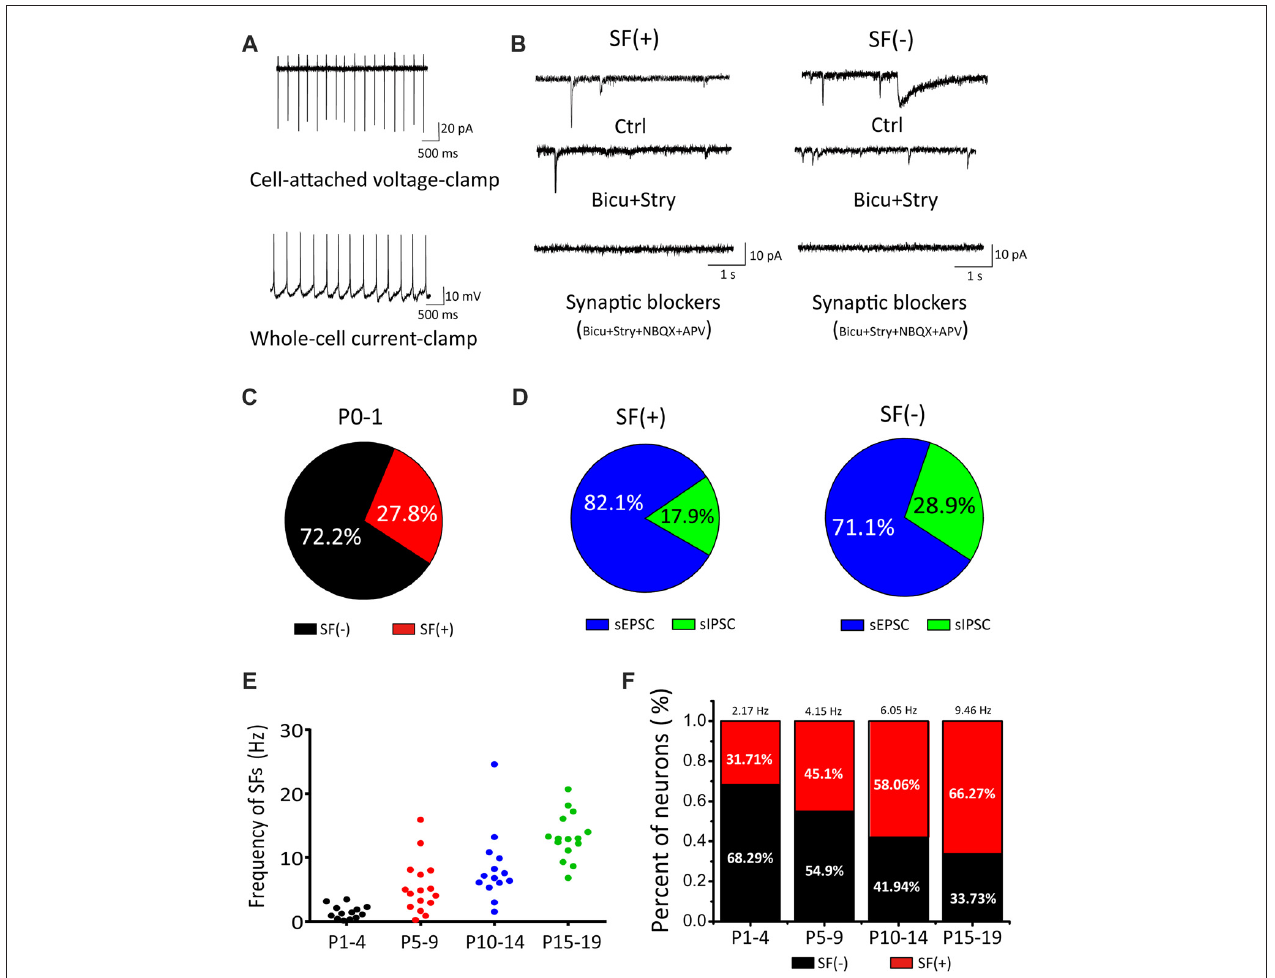
FIGURE 1 | Cochlear nucleus (CN) neurons exhibited spontaneous firings (SFs) in the early postnatal stage. (A) Examples showing cell-attached recordings of SFs in voltage-clamp or current-clamp mode. (B) Typical spontaneous synaptic currents recorded in three sequential conditions (control, bicu+stry, bicu+stry+NBQX+APV) in SF(+) and SF( − ) neurons. (C) Pie charts showing the percentage of SF(+) and SF( − ) neurons. (D) The proportion of spontaneous inhibitory postsynaptic currents (sIPSCs) and spontaneous excitatory postsynaptic currents (sEPSCs) detected in SF(+) and SF( − ) neurons, respectively. (E) A scattered dot plot showing developmental-dependent changes in the firing rate of 58 SF(+) CN neurons from P1–4, P5–10, P11–14 and P15–19 mice. (F) A bar graph summarizing the percentages of SF(+) and SF( − ) neurons for four age groups with the mean firing rate for SF(+) neurons given (P1–4: 2.17 Hz, 32%; P5–10: 4.15 Hz, 45%; P11–14: 6.05 Hz, 58%; P15–19: 9.46 Hz,